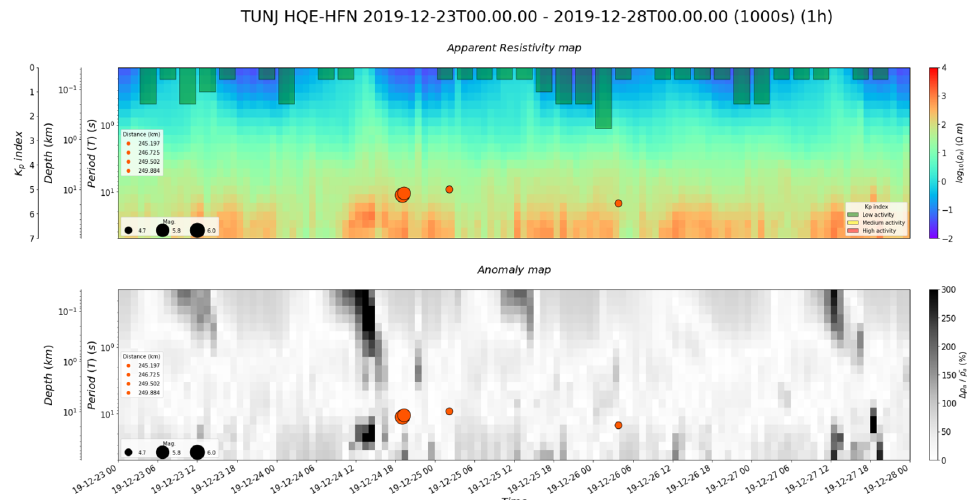
Figure 7. Anomalies registered at TUNJ station for the same Mesetas